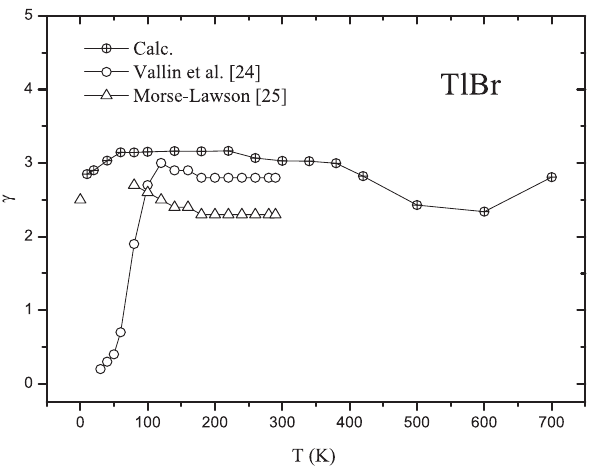
Fig. 6: The Grüneisen constant γ for